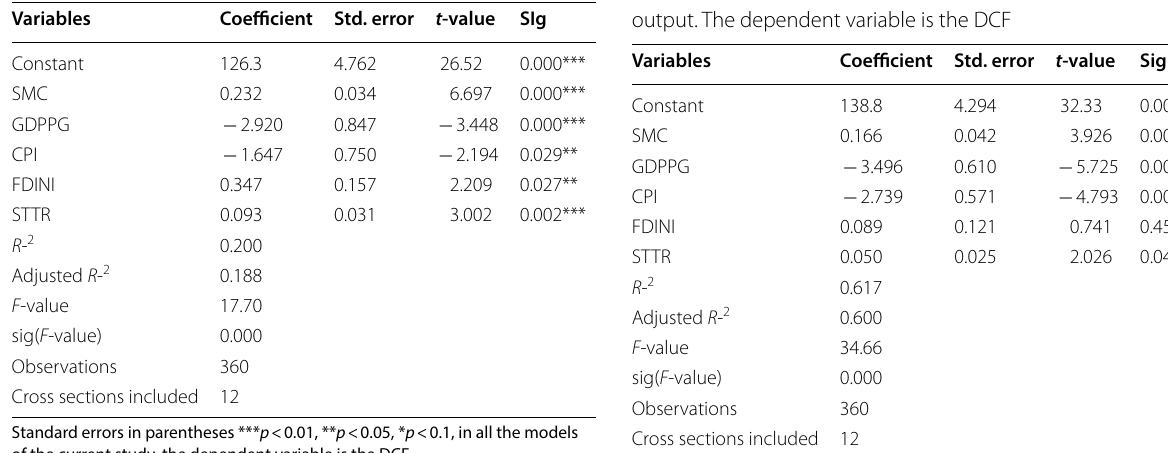
Table 4 Penal OLS regression. Source: Software of E-views 10